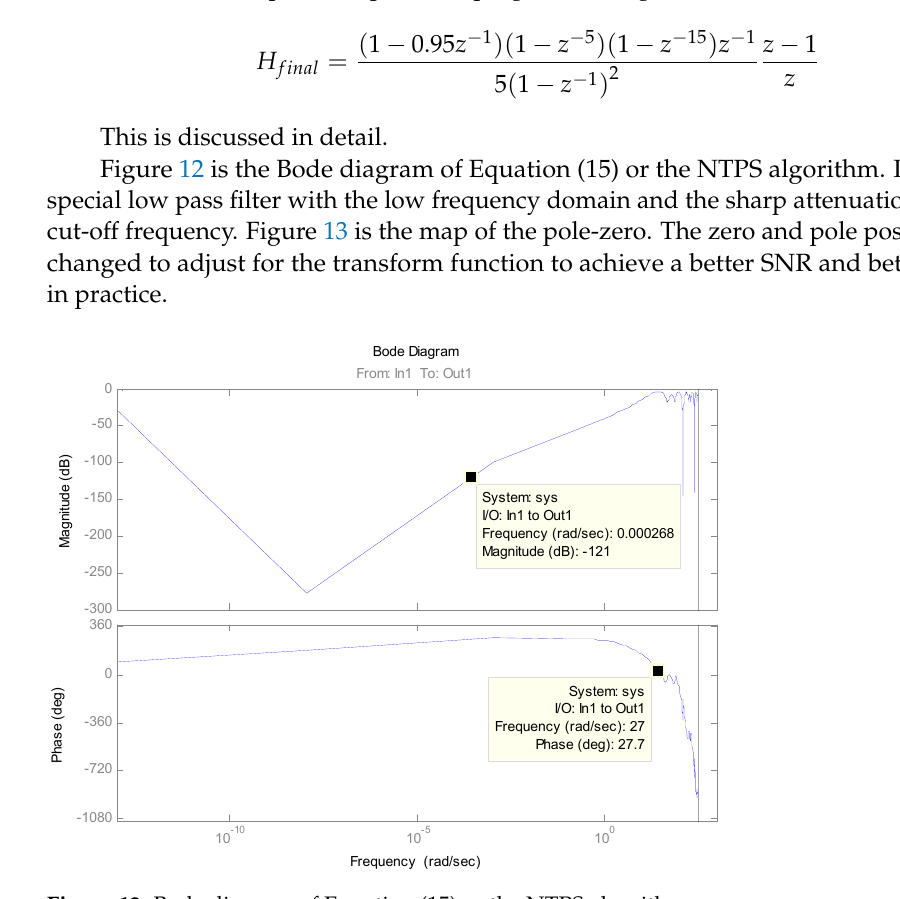
Figure 12. Bode diagram of Equation (15) or the NTPS algorithm.